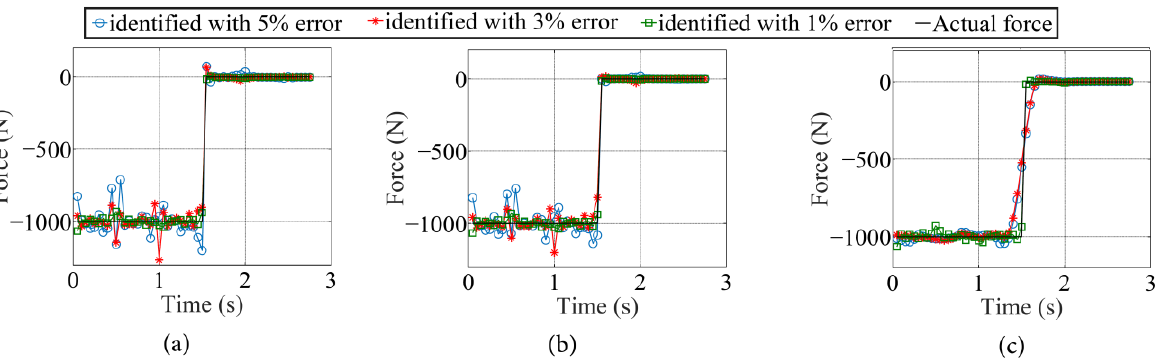
Figure 11. The identified step load with five sensors and ( a ) no regularization, ( b ) γ = 10 − 22 , and ( c ) γ = 10 − 18 .